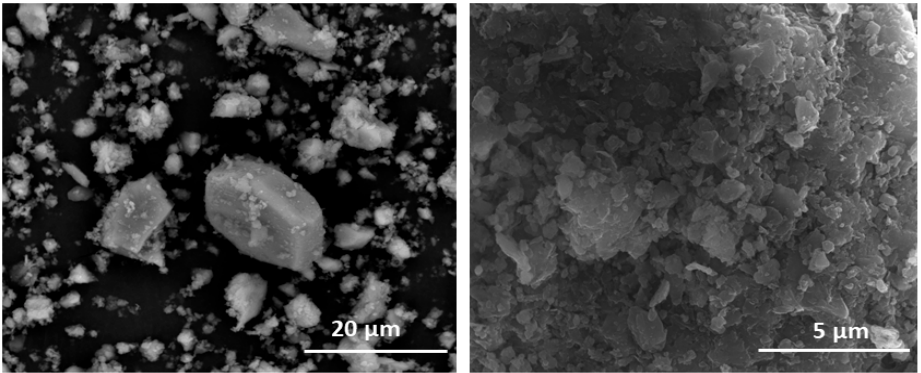
Figure 6. ( left ) Siliceous aggregates in HsT waste. ( right ) Detail of surface deposits on HsS waste. Table 3. Energy dispersive X-ray spectroscopy (EDX) chemical analysis of limestone waste. Oxide (%)